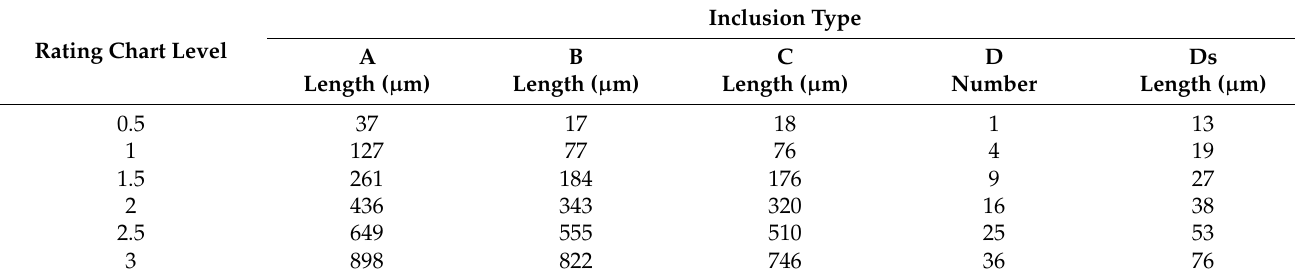
Table 7. The rating limits of various inclusions.